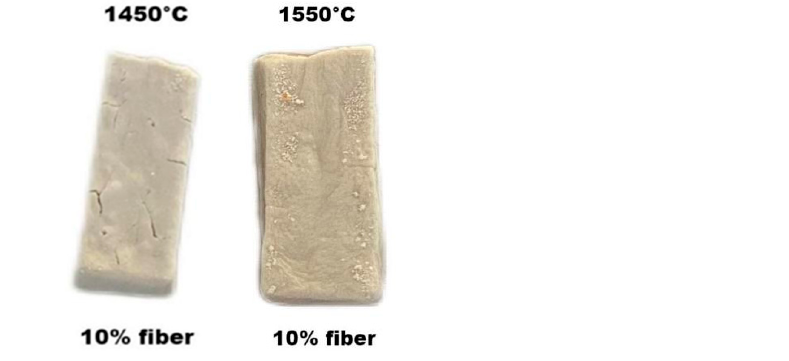
Figure 12. The surface of 10% fiber-added samples after 1450 °C and 1550 °C treatment.